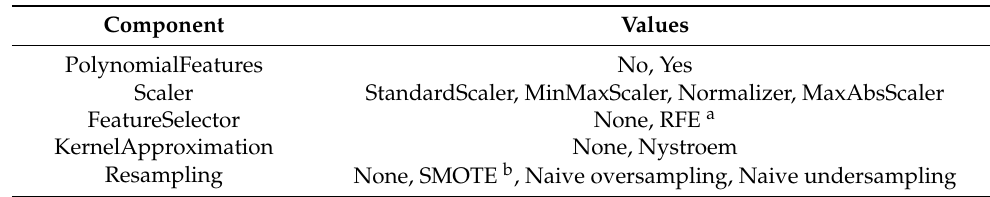
Table 3. The pipeline search space in experiments where feature-based input was used. The table follows the order of the components in a pipeline.